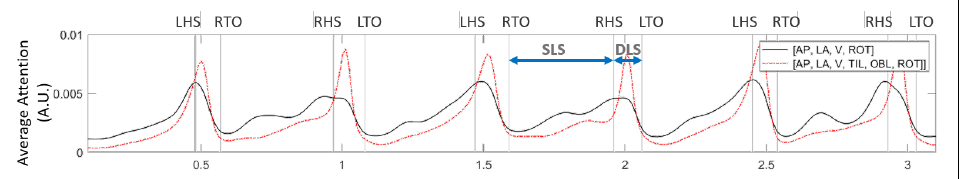
Figure 11. Average Attention plotted for the stacked-LSTM model using all 6 input pelvis signals and limited 4 input signals. The models put more attention to DLS phase between right HS and left TO as compared to the SLS between right TO and right